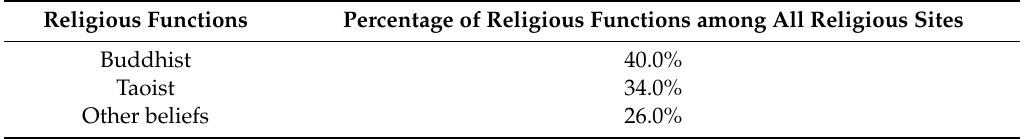
Table 1. Percentage of religious functions among all religious sites included in the Southern